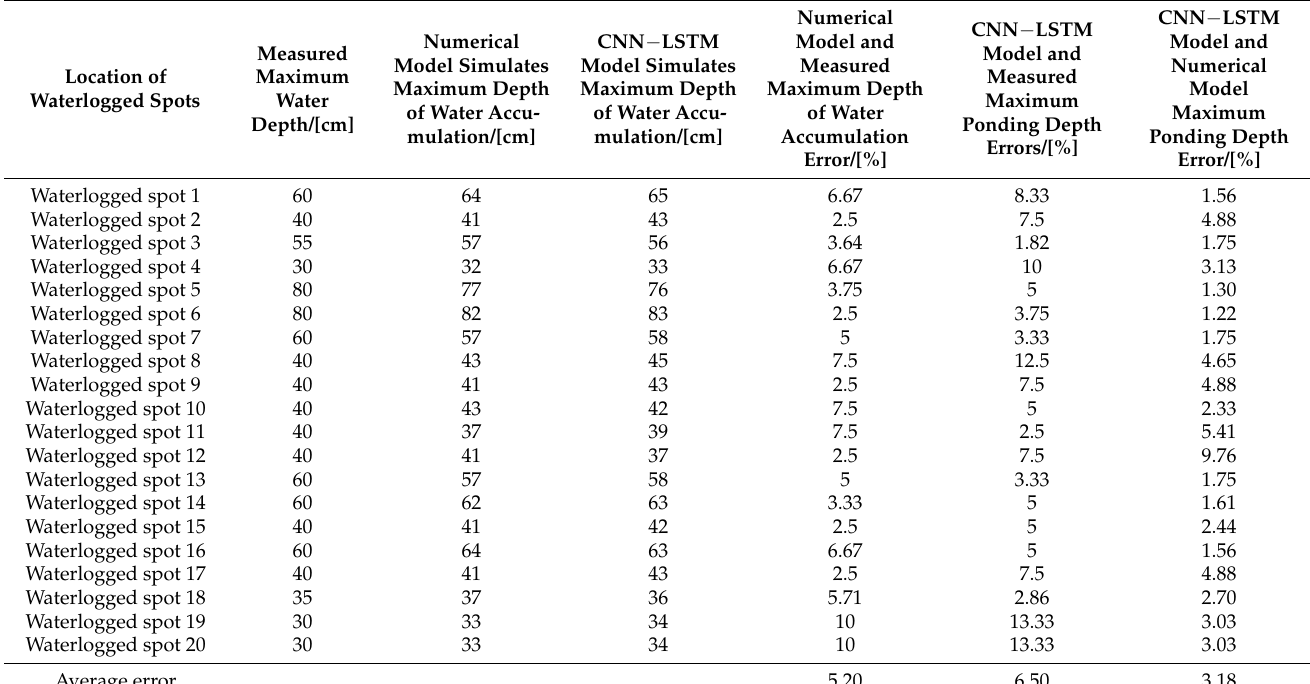
Table 3. Comparison of measured and simulated water depths at inundated water accumulation points for 20 July